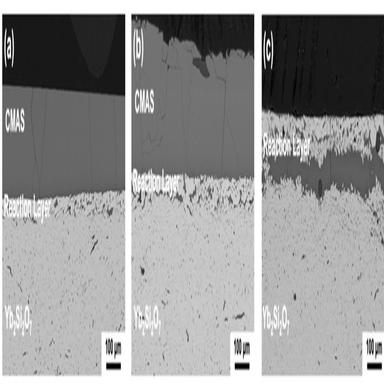
Cross-sectional SEM micrographs of Yb2Si2O7 samples exposed to CMAS corrosion at 1300 ◦C for (a) 2 h, (b) 12 h and (c) 24 h.